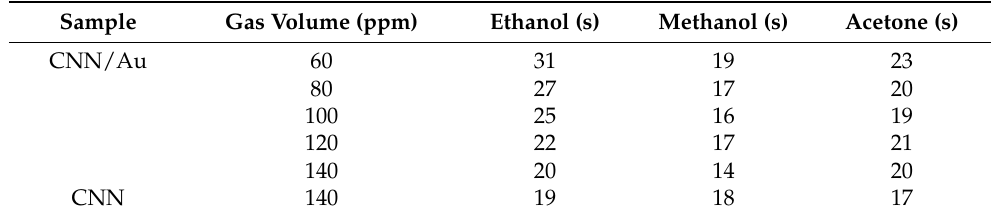
Table 2. The recovery times of the CNN- and CNN/Au-based sensor for different ppm of acetone, methanol, and ethanol.